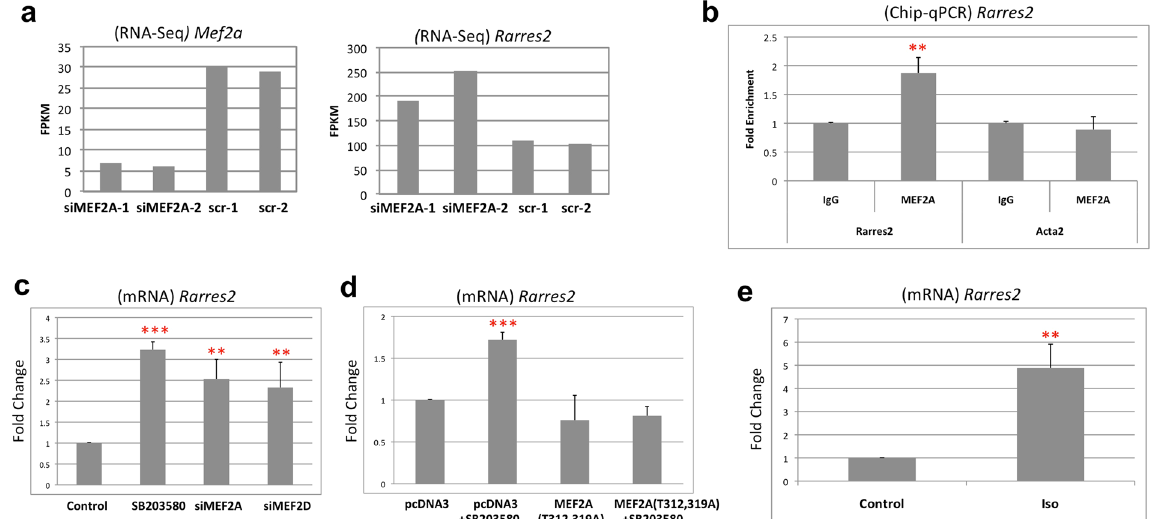
Figure 6. Rarres2 is regulated by MEF2. ( a ) Expression of Mef2a and Rarres2 in RNA-seq analysis of MEF2A depleted cardiomyocytes (fragments per kilobase of exon per million fragments mapped). ( b ) ChIP-qPCR analysis demonstrates that MEF2A is recruited to the Rarres2 promoter in primary cardiomyocytes. Data are presented as fold enrichment (n = 3, ** P < 0.01). Acta2 was used as a negative control. ( c ) Rarres2 expression is negatively regulated by MEF2 in a p38 MAPK dependent manner. Primary cardiomyocytes were transfected with siRNA targeting MEF2A, MEF2D or a scrambled siRNA control and treated with SB 203580 (5 μ M) for 24 hours. Control cells were treated with an inactive analogue, SB 202474. Data were normalized to Gapdh and are presented as fold change using the delta delta Ct method (n = 3, ** P < 0.01, *** P < 0.001). ( d ) Phosphorylation defective mutated MEF2A prevents Rarres2 induction by p38 inhibition. Primary cardiomyocytes were transfected with empty vector (pcDNA3) or a mutated MEF2A expression construct (T312, 319A) and treated with SB 203580 or SB 202474 (5 μ M) for 24 hours. Data were analyzed as in 6c (n = 3, ** P < 0.01). ( e ) Isoproterenol (Iso; 10 μ M) treatment for 24 hours, upregulates Rarres2 expression. Data were normalized to Gapdh and are presented as fold change as in 6c (n = 3, ** P <